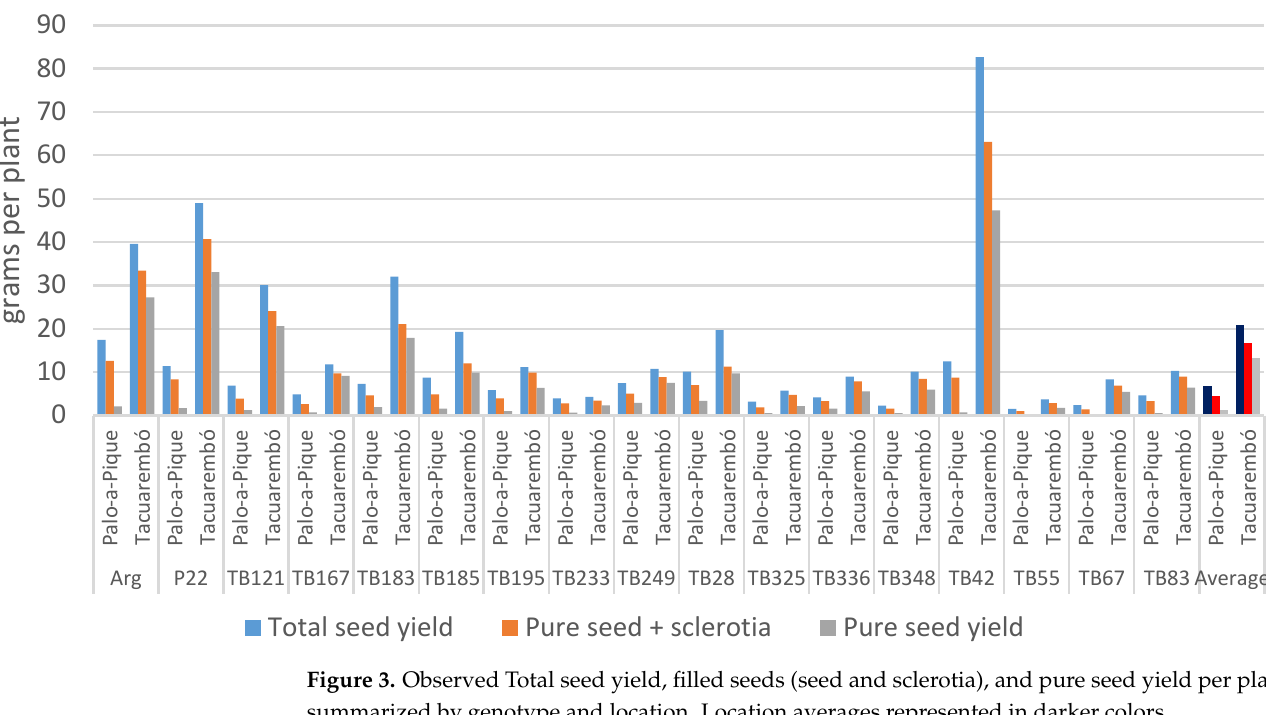
Table 4. Pearson correlation coefficients and probabilities between total seed yield components.